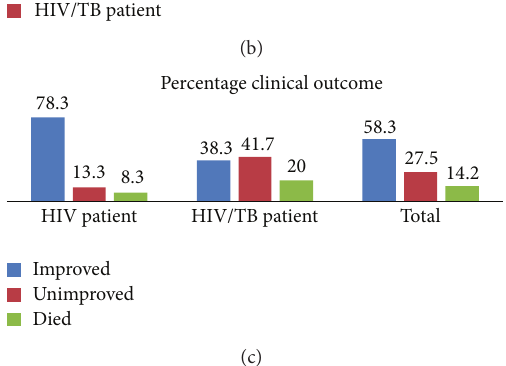
Figure 1: (a) Percentage weight gain or loss observed. (b) Patients’ gain or loss in CD4 cells/mm 3 . (c) Physical improvement and death.